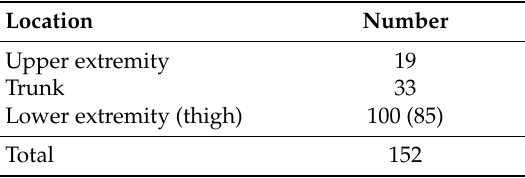
Table 4. Locations of the